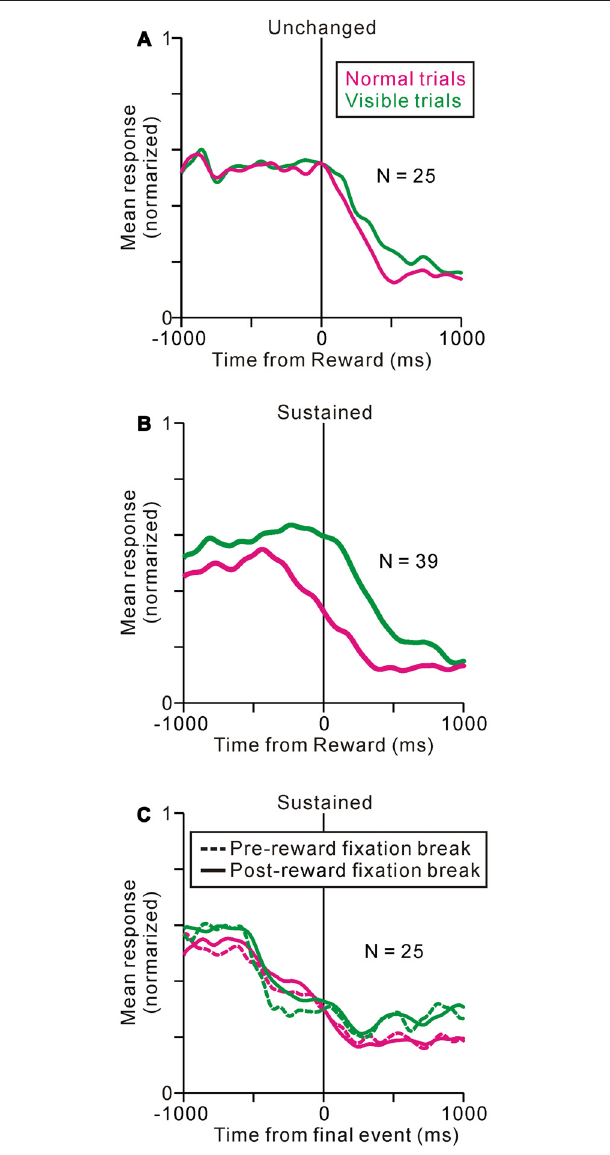
FIGURE 5 | Population average activity during normal (magenta) and visible (green) tasks are shown separately for unchanged- (A) and sustained- (B,C) type neurons. The data are aligned to the time of reward delivery (A,B) and the end of an individual trial (C) . (C) The data are further separated into pre- (dotted line) and post-reward (solid line) fixation break